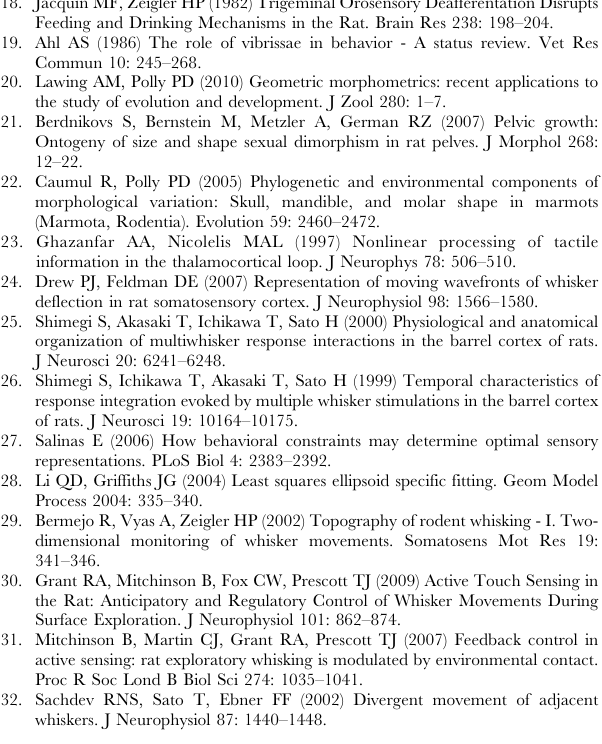
Table S2 All models tested for parameter-identity